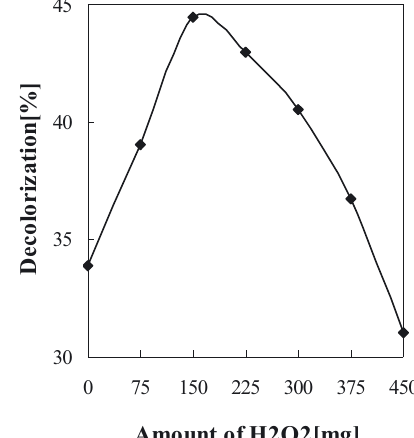
O on photocatalytic decolorization. 2 2